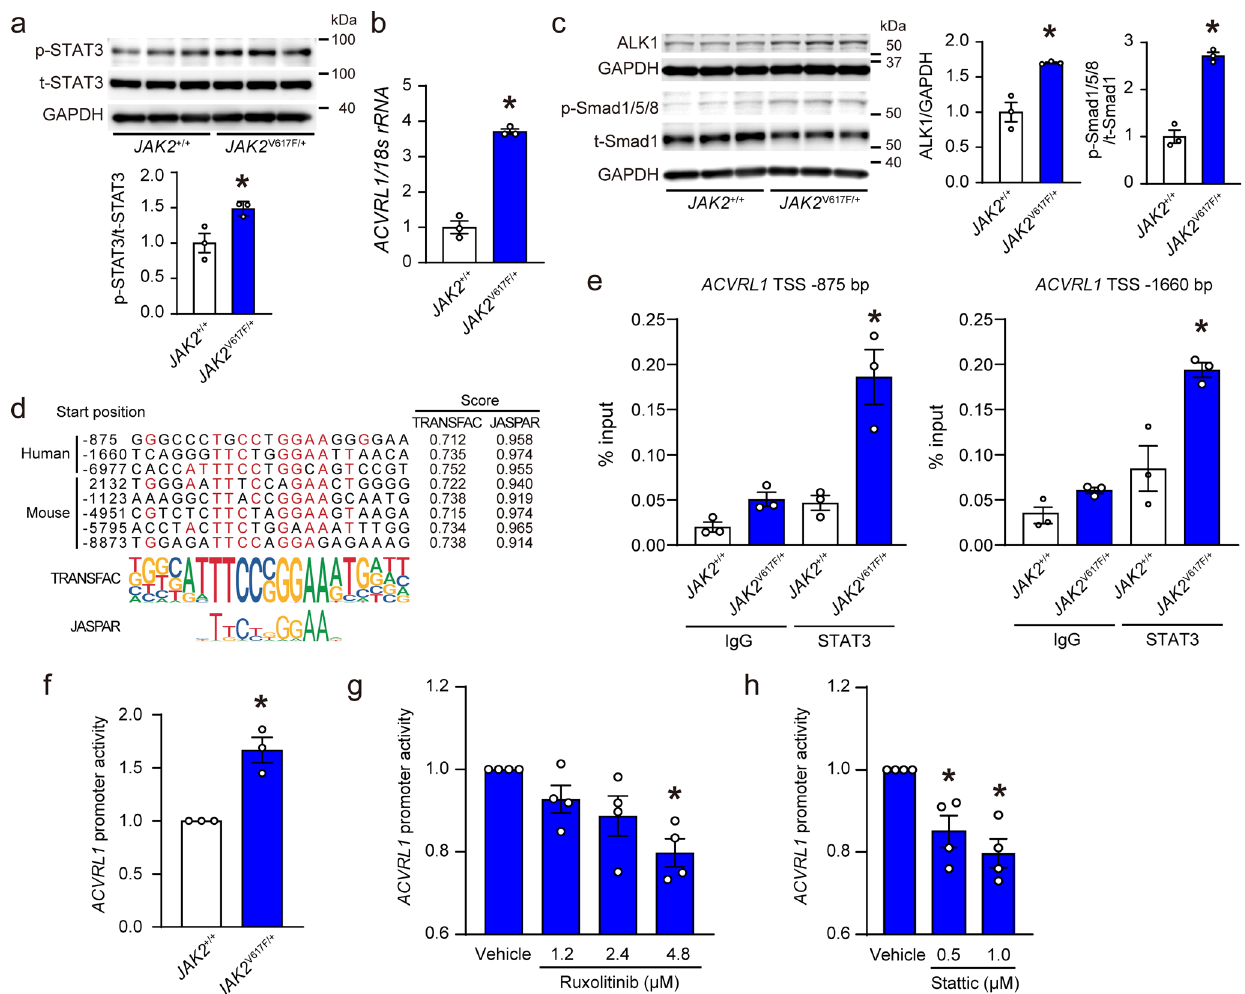
Fig. 7 JAK2 V617F transcriptionally upregulates ACVRL1 by STAT3-binding. a Western blot analysis of STAT3 in JAK2 V617F/ + knock-in HCT116 cells. p-STAT3 and t-STAT3 indicate phosphorylated and total STAT3, respectively. p-STAT3 to t-STAT3 ratios are shown in the bar graph ( n = 3, * P = 0.0296). The average value of JAK2 + / + HCT116 cells was set to 1. b mRNA expression in ACVRL1 in JAK2 V617F/ + cells. The data were normalized to 18 s rRNA levels. The average value of JAK2 + / + cells was set to 1 ( n = 3, * P = 0.0001). c Western blot analysis of the ALK1-SMAD pathway. The graphs show the densitometric analysis for ALK1, p-Smad1/5/8 and t-Smad1 ( n = 3 in each, * P = 0.0070, 0.0004, respectively). p-Smad1/5/8 and t-Smad1 indicate phosphorylated Smad1/5/8 and total Smad1, respectively. GAPDH was used as the loading control. d Sequence alignments of putative STAT3 binding sites of Acvrl1 in human (hg19) and mouse (m10). Numbers are given according to the genomic sequence from transcriptional start site (TSS). The sequences of the STAT3 binding motifs are highlighted in red. Sequence logos for the motifs analyzed by TRANSFAC and JASPAR databases are displayed. e